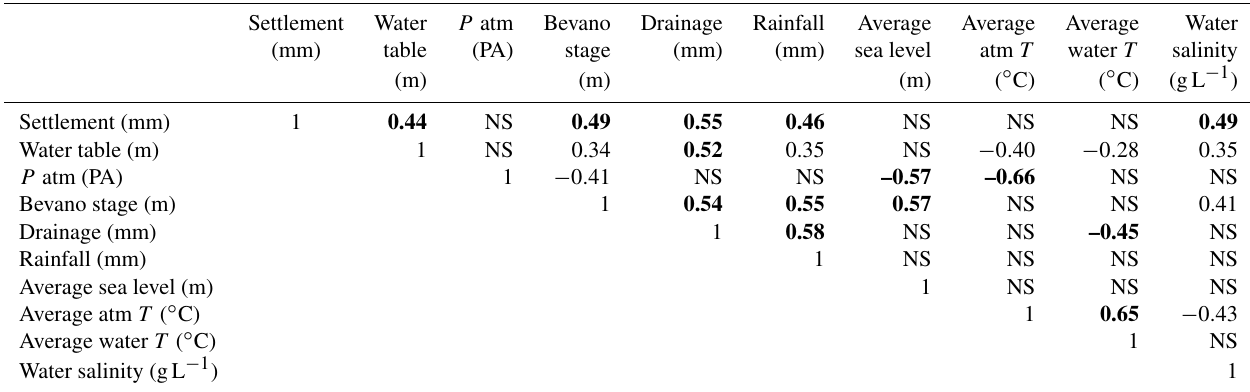
Table 1. Monthly correlation coefficients (from Antonellini et al., 2019). Bold values are for a very good correlation and NS means not significant.